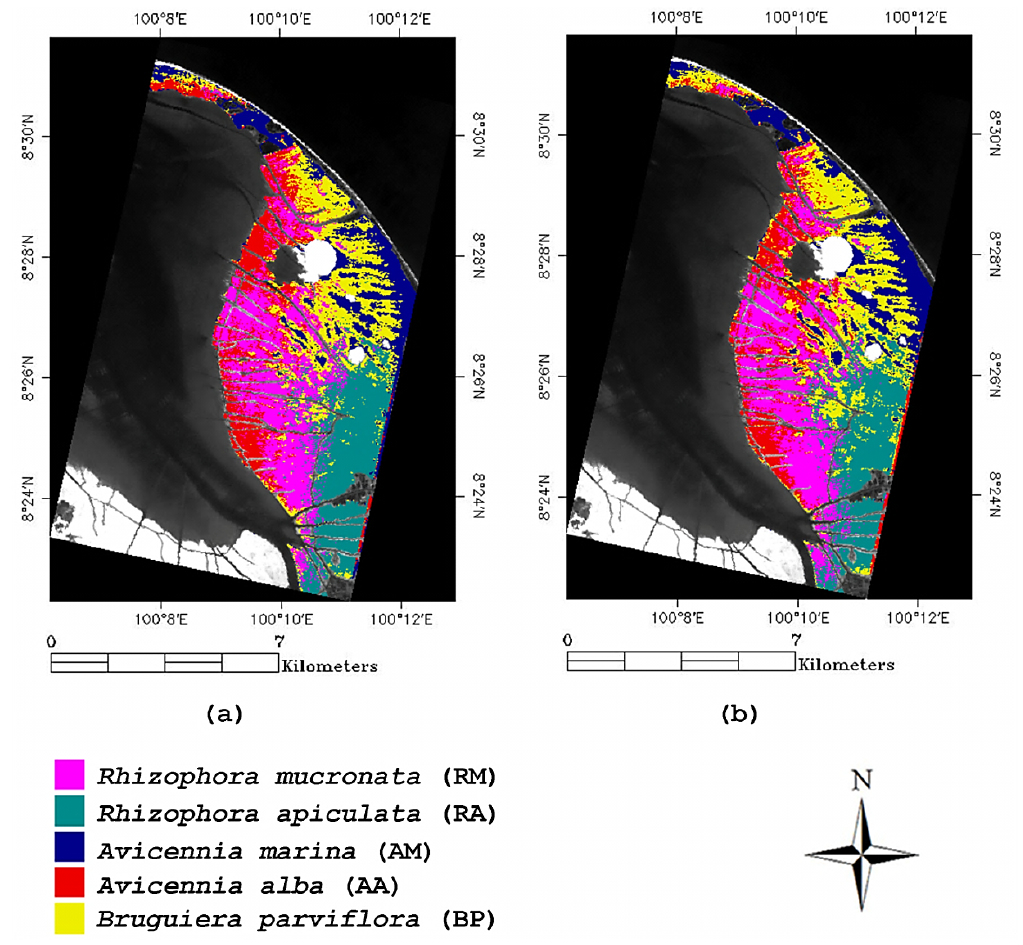
Figure 6. ( a ) The classified image of the winning chromosome selected by the genetic search algorithm (Overall Accuracy = 92%) and ( b ) the classified image of the 7 spectral-band combination selected by the SFS feature selector (Overall Accuracy =